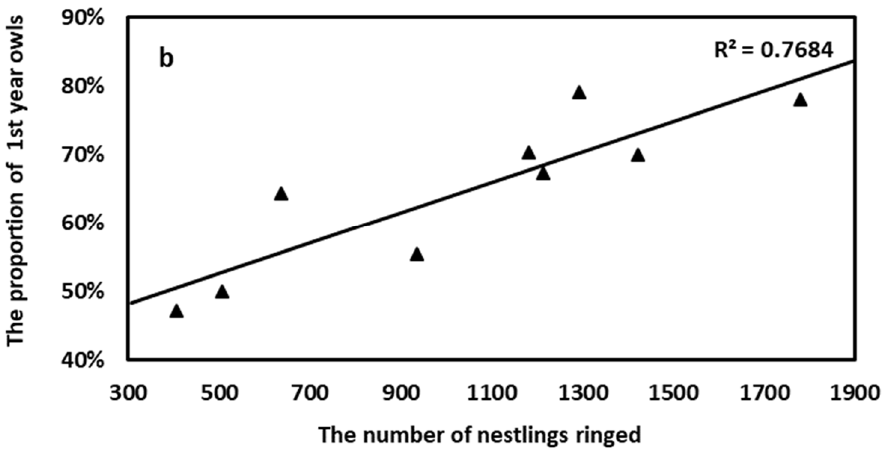
Figure 6. ( a , b ) The proportion of barn owl roadkills from 2009 to 2017 that were less than one year old was positively related to the number of breeding pairs ( a ) and the number of nestlings ringed ( b ).